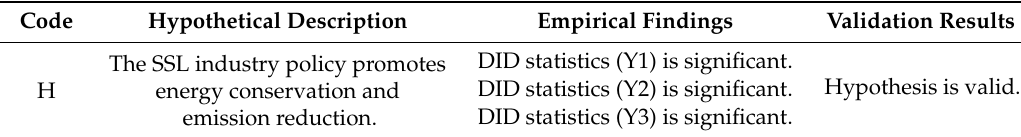
Table 12. Validation results of model research